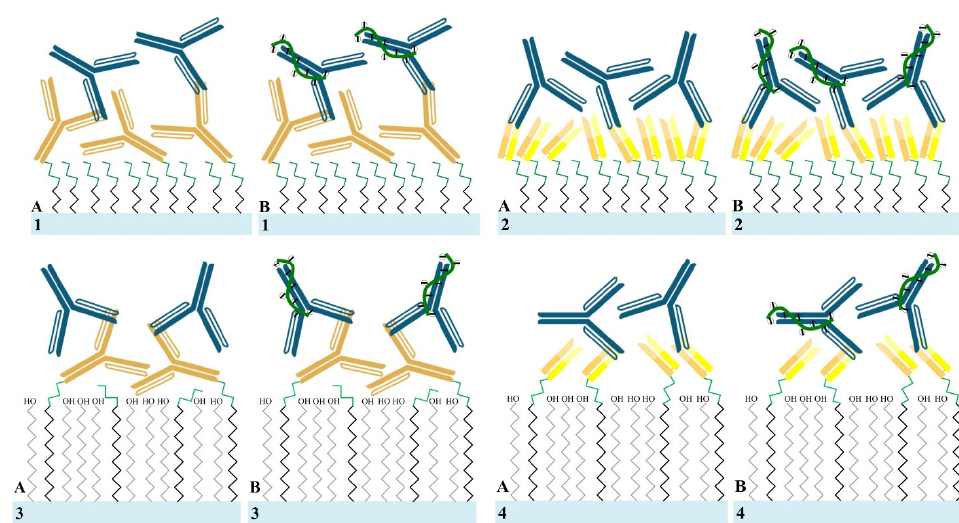
Figure 3. Illustration of the detection of rabbit IgG by (1) Wab/APTES-SiNWFETs, (2) Fab/APTES-SiNWFETs, (3) Wab/PEG-SiNWFETs, and (4) Fab/PEG-SiNWFETs as well as their corresponding signal enhancement by R18 aptamer in this study. Both of the Wab/APTES-SiNWFETs (sample 1) and Fab/APTES-SiNWFETs (sample 2) were used to detect ( A ) rabbit IgG (blue Y shapes) at concentrations of 100 pg/mL and 1 ng/mL, before binding with ( B ) 3 µ g/mL R18 aptamer (green curves) for signal enhancement. The Wab/PEG-SiNWFETs (sample 3) could only determine ( A ) rabbit IgG (blue Y shapes) at concentrations of 10 pg/mL, 100 pg/mL and 1 ng/mL, whereas the Fab/PEG-SiNWFETs (sample 4) could recognize ( A ) rabbit IgG (blue Y shapes) at concentrations of 1 pg/mL, 10 pg/mL, 100 pg/mL, and 1 ng/mL. Both of them were then also incubated in ( B ) 3 µ g/mL R18 aptamer (green curves) for signal enhancement. All the biosensing experiments in this Figure were performed in 150 mM